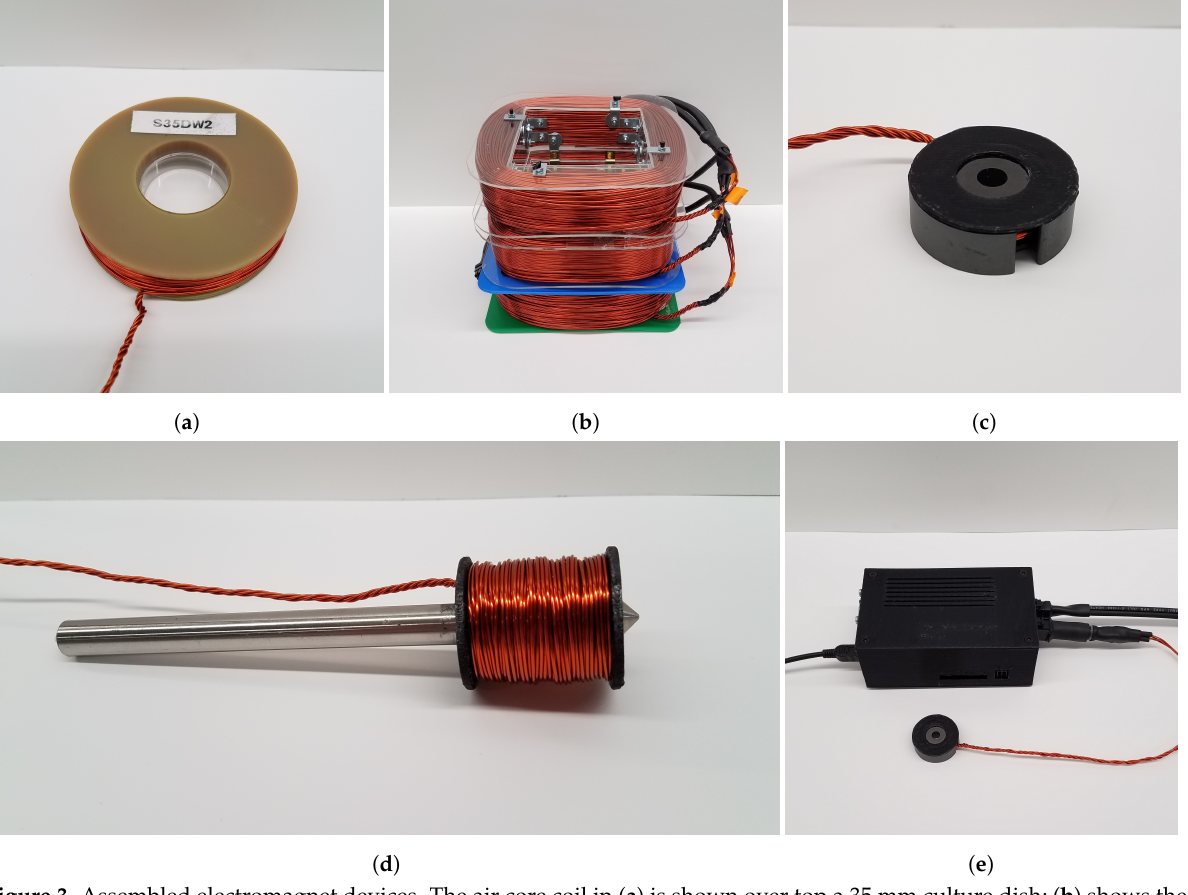
Figure 3. Assembled electromagnet devices. The air core coil in ( a ) is shown over top a 35 mm culture dish; ( b ) shows the stacked three-coil system, where each coil is connected in series; ( c ) pot core design shown with the unshielded, open side up; ( d ) ferromagnetic core coil; ( e ) The stimulation controller is pictured connected to a laptop with USB, the power supply which delivers the DC stimulation current, and the pot core